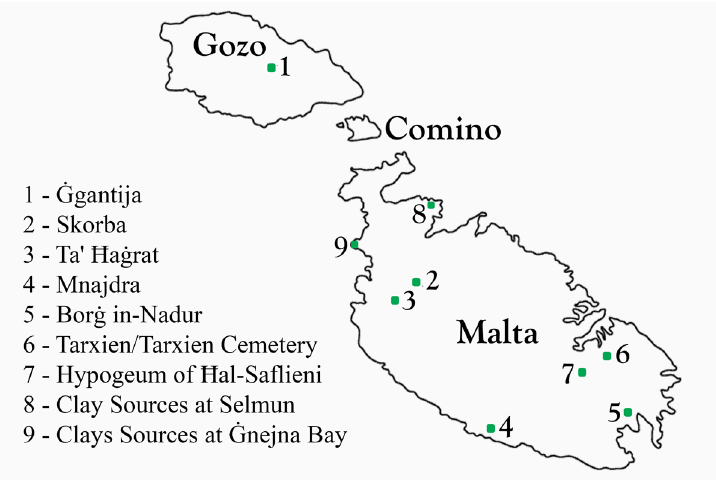
Figure 2. Map of Maltese islands showing the locations of the archaeological sites and locations of clay outcrops included in this